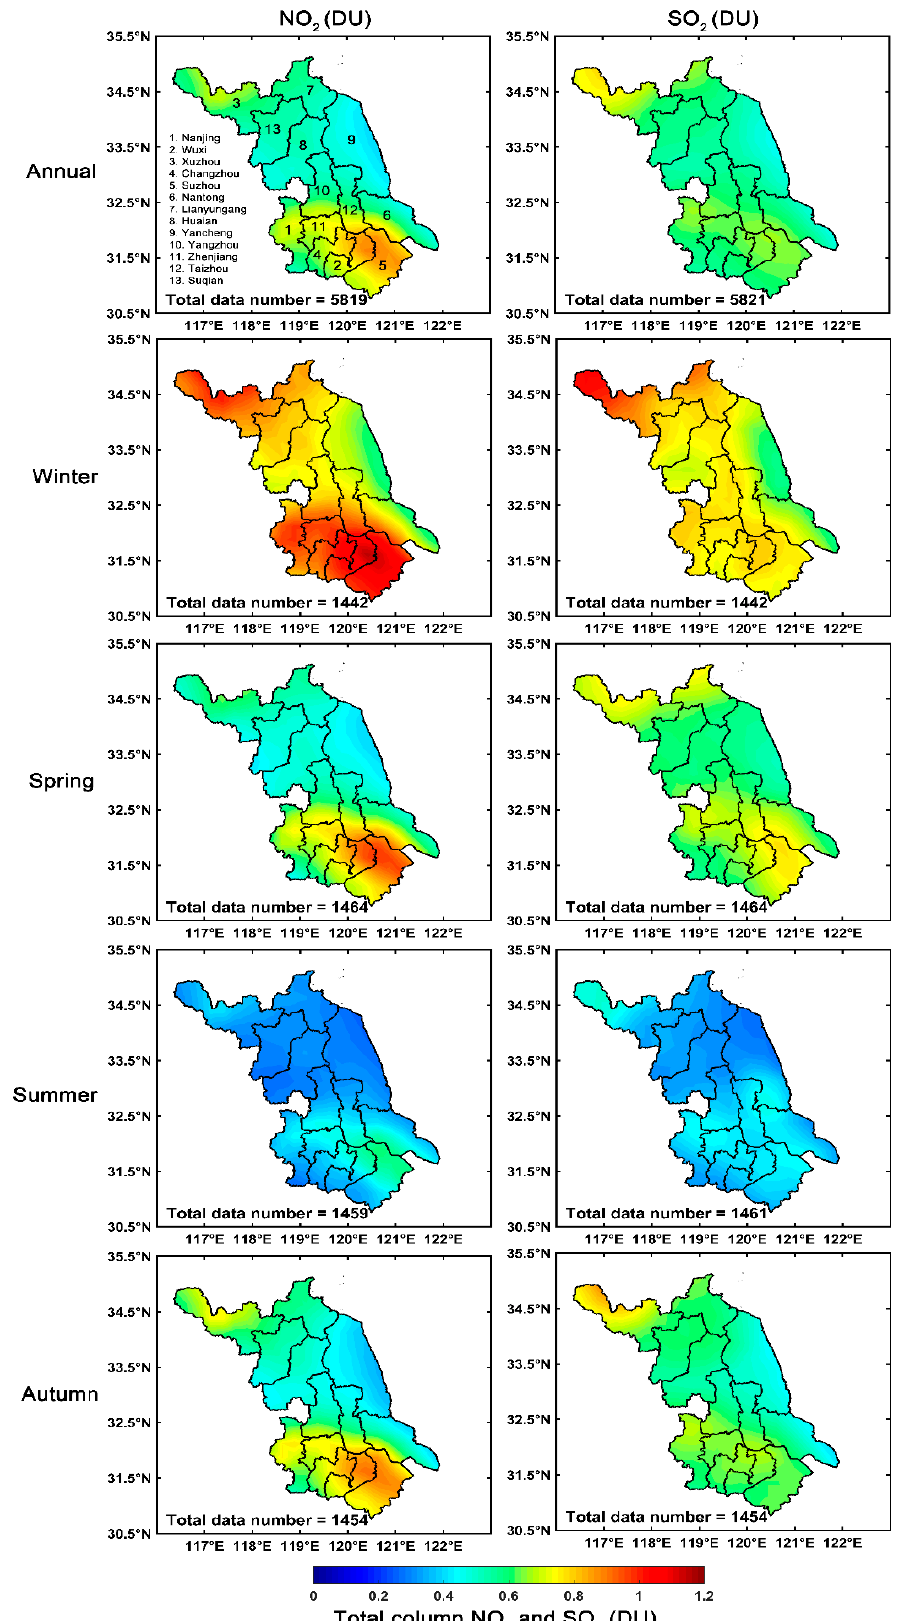
Figure 2. Annual and seasonal spatial distribution of OMI-retrieved NO 2 (DU) and SO 2 (DU) over Jiangsu Province from 2005 to 2020.